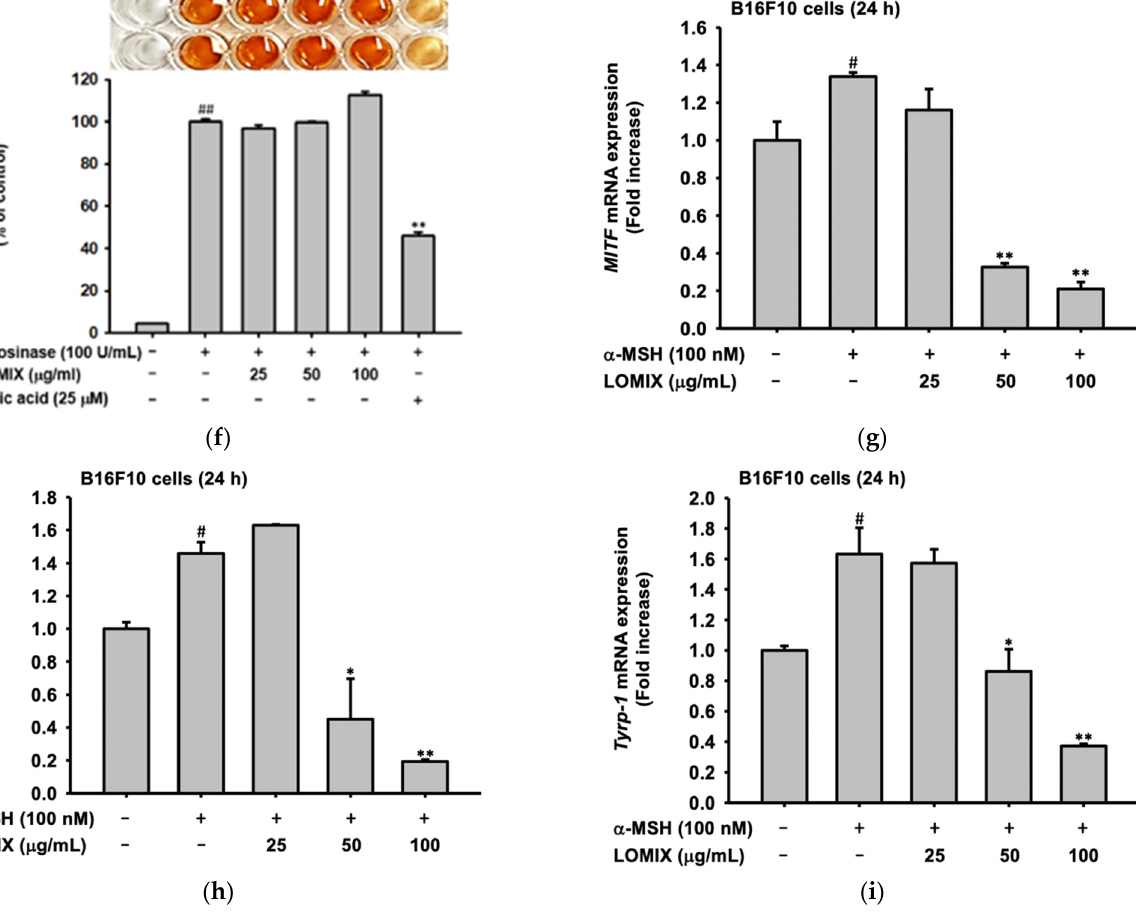
Figure 2. The activity of LOMIX in B16F10 cells. ( a , d ) B16F10 melanoma cells were treated at described concentrations of LOMIX for 0, 24, and 48 h, and cell viability was detected by MTT assay. ( b , c ) B16F10 cells pretreated with LOMIX were treated with α -MSH for 48 h, and melanin levels in cells ( b ) or media ( c ) were determined at 405 nm. ( e ) The cell cycle level controlled by LOMIX was determined by PI staining and Flow cytometry analysis with B16F10 melanoma cells treated with α -MSH and LOMIX for 48 h. ( f ) Tyrosinase inhibition assay was conducted using mushroom tyrosinase and L-DOPA. Kojic acid was used for positive controls in this experiment. ( g – i ) The mRNA levels of melanin production-related genes (MITF, Tyrosinase, and TYRP-1) were confirmed by a real-time PCR assay in B16F10 melanoma cells incubated with α -MSH and LOMIX for 24 h. ( a – i ) Values represent the mean ± standard deviation (SD) of three independent experiments. # p < 0.05 and ## p < 0.01 compared with normal via Mann-Whitney U test. * p < 0.05 and ** p < 0.01, compared with α -MSH-treated group via Mann-Whitney U